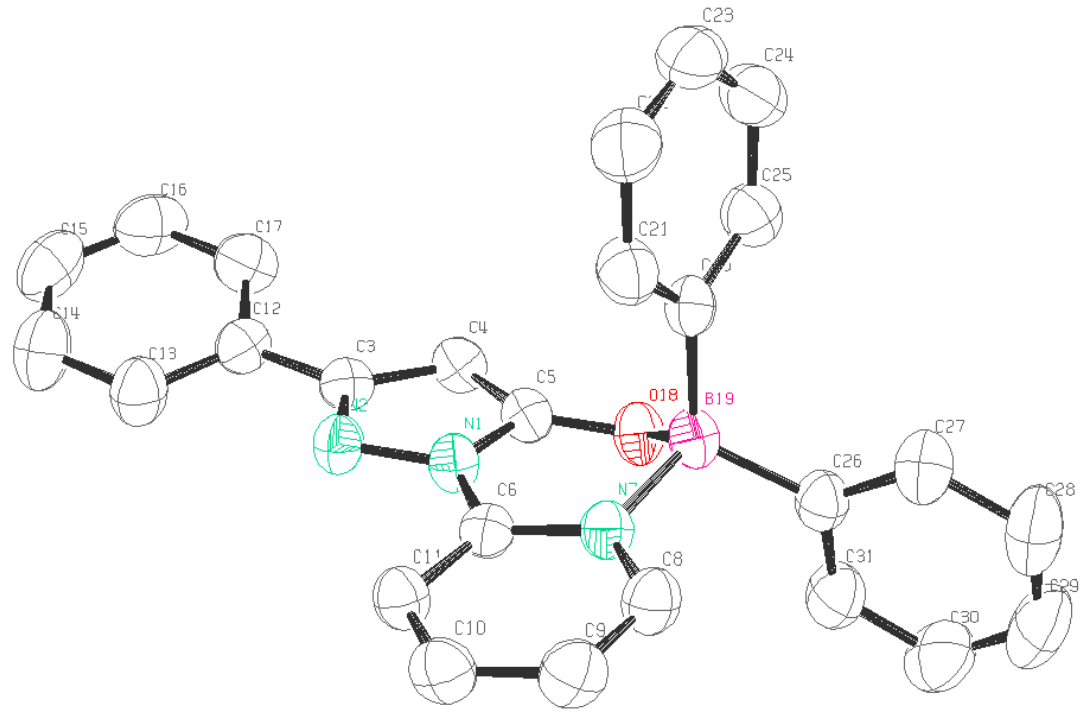
Figure 1. The crystal structure of 2c .